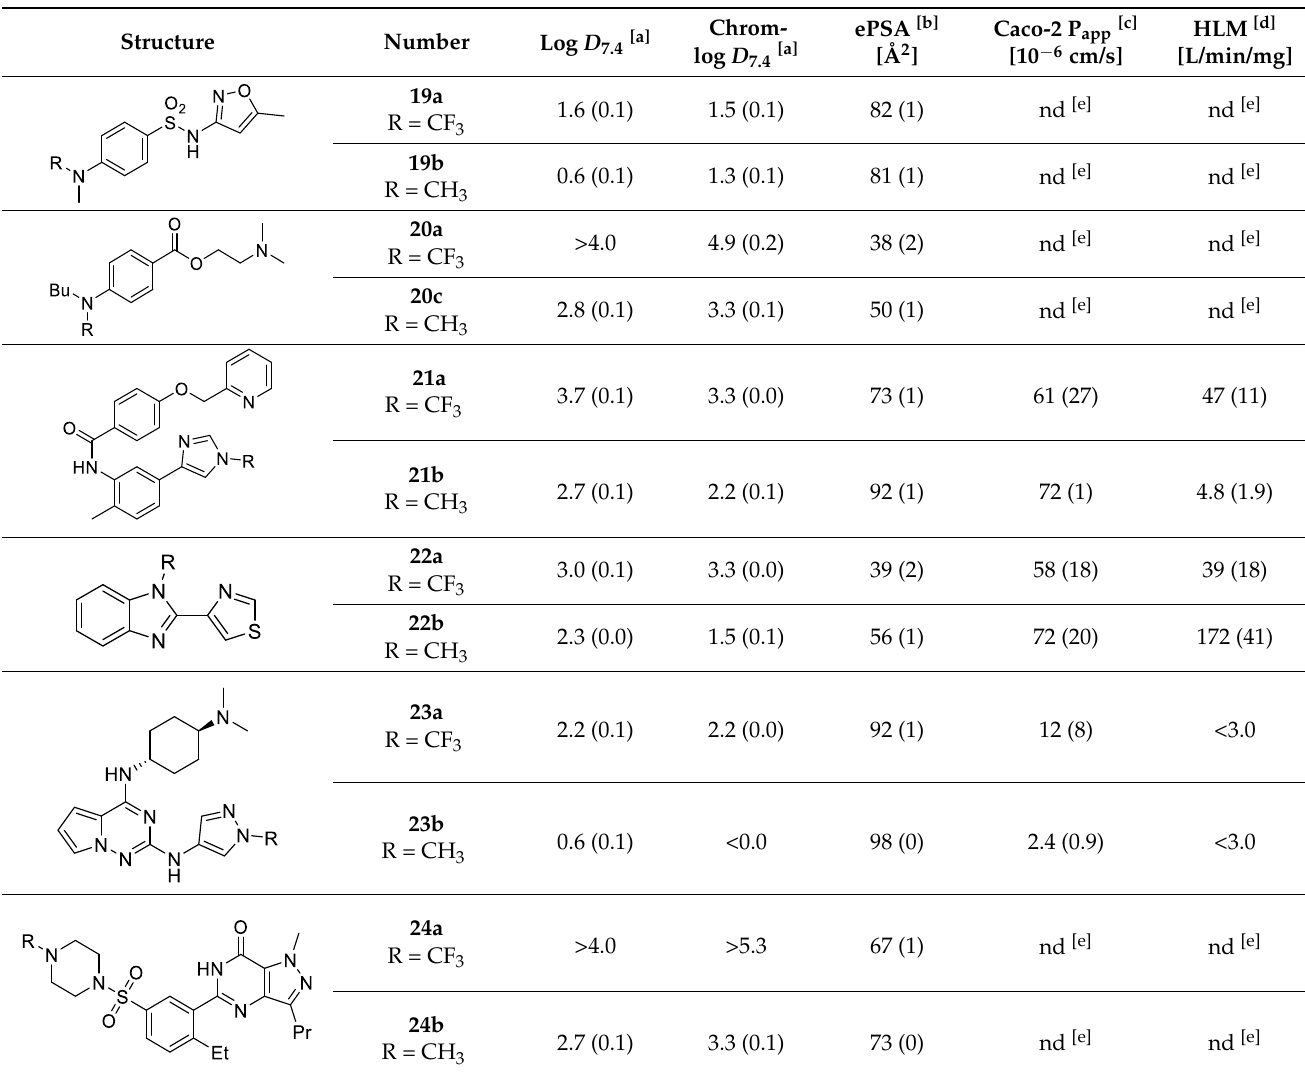
Table 2. Overview of the change in key in vitro properties when exchanging N -CH 3 and N -CF 3 [f] .